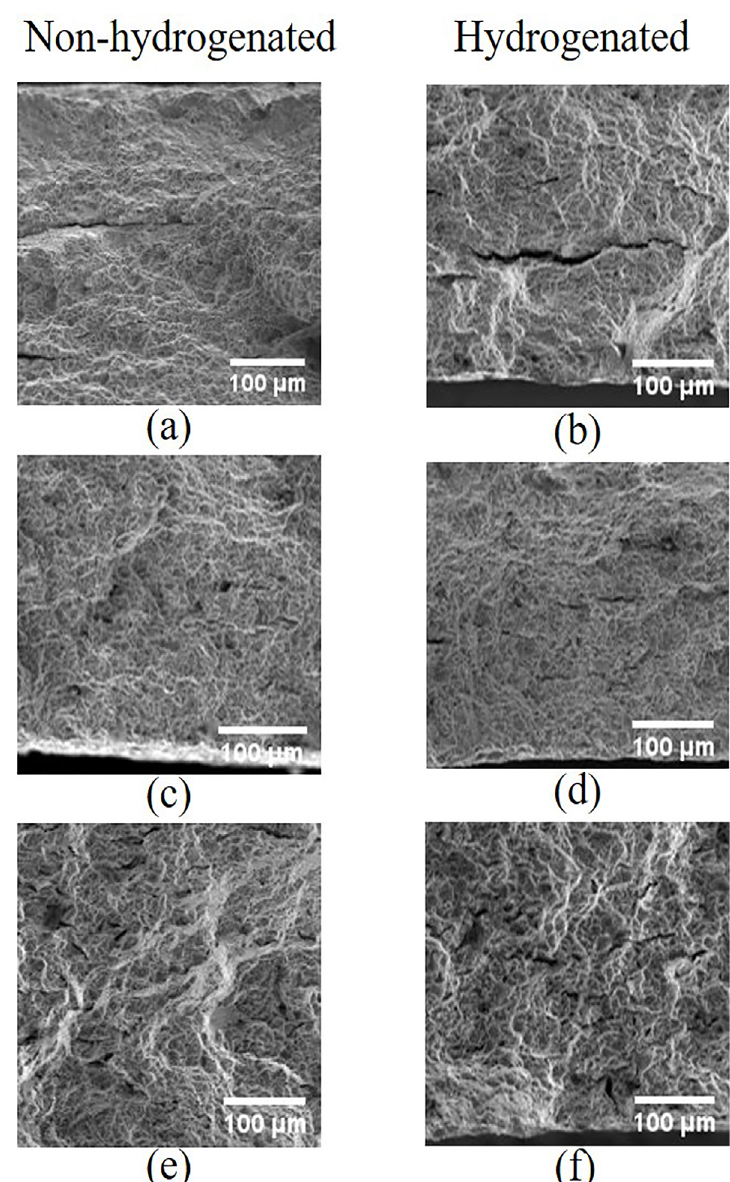
Figure 8. Fractography after tensile test for the proposed alloys under non-hydrogenated and hydrogenated conditions. a) Zr-0.9Nb-0.1Mn without H; b) Zr-0.9Nb-0.1Mn with H; c) Zr-0.8Nb-0.2Mn without H; d) Zr-0.8Nb-0.2Mn with H; e) Zr-0.6Nb-0.4Mn without H and f) Zr-0.6Nb-0.4Mn with